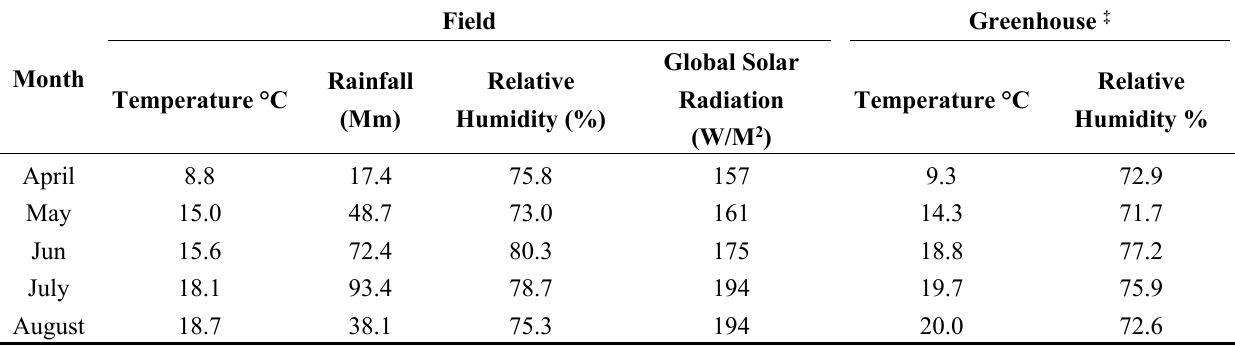
Table 3. Monthly average temperature (°C), precipitation (mm), relative humidity (%), and global solar radiation in the field and greenhouse during the 2012 growing season at